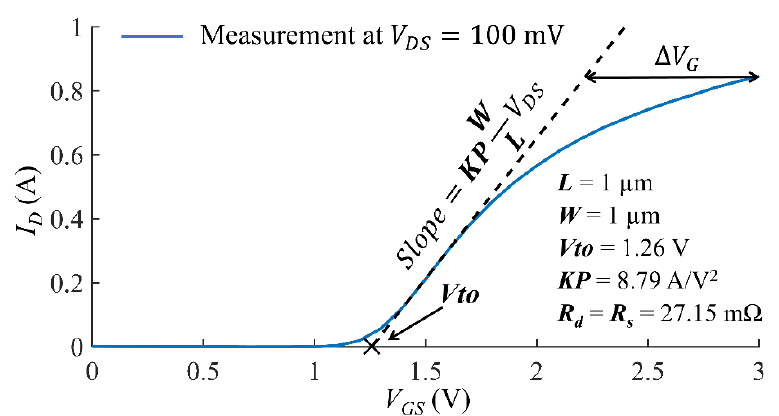
Figure 2. Extraction of KP , Vto , Rs , and Rd from measured transfer characteristic of GS66504B GaN-HEMT.